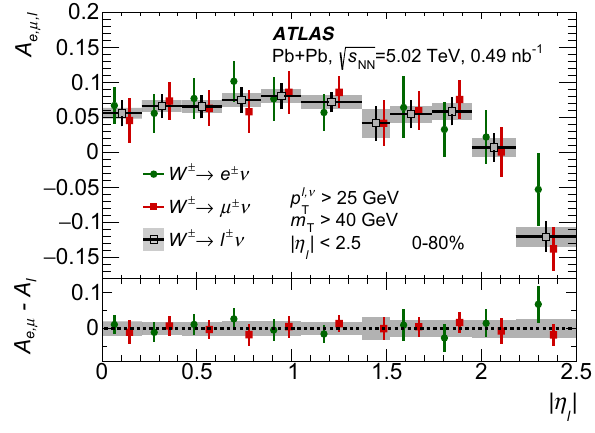
Fig. 8 Lepton charge asymmetry as a function of absolute pseudora- pidity of the charged lepton, | η (cid:4) | , measured for W ± bosons decaying intoelectronsandmuons aswellasforthecombinationof thetwochan- nels. Statistical and systematic uncertainties of the combined charge asymmetry are shown as bars and shaded boxes, respectively. For the individual channels, only the total uncertainties are shown as error bars. The lower panel shows the differences between the asymmetries mea- sured for each channel separately and their combination with error bars andshadedboxesrepresentingthetotaluncertaintiesofthechannelsand combined asymmetry, respectively. The points for individual channels are shifted horizontally for better